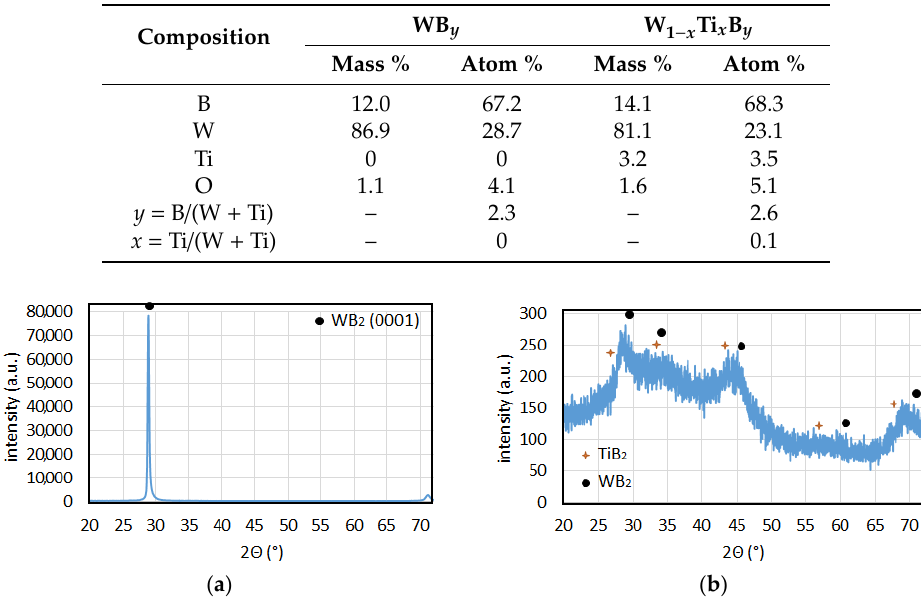
Figure 4. X-ray diffraction patterns of deposited coatings: ( a ) columnar crystalline WB 2 ; ( b ) amorphous/nanocrystalline (W,Ti)B 2 .